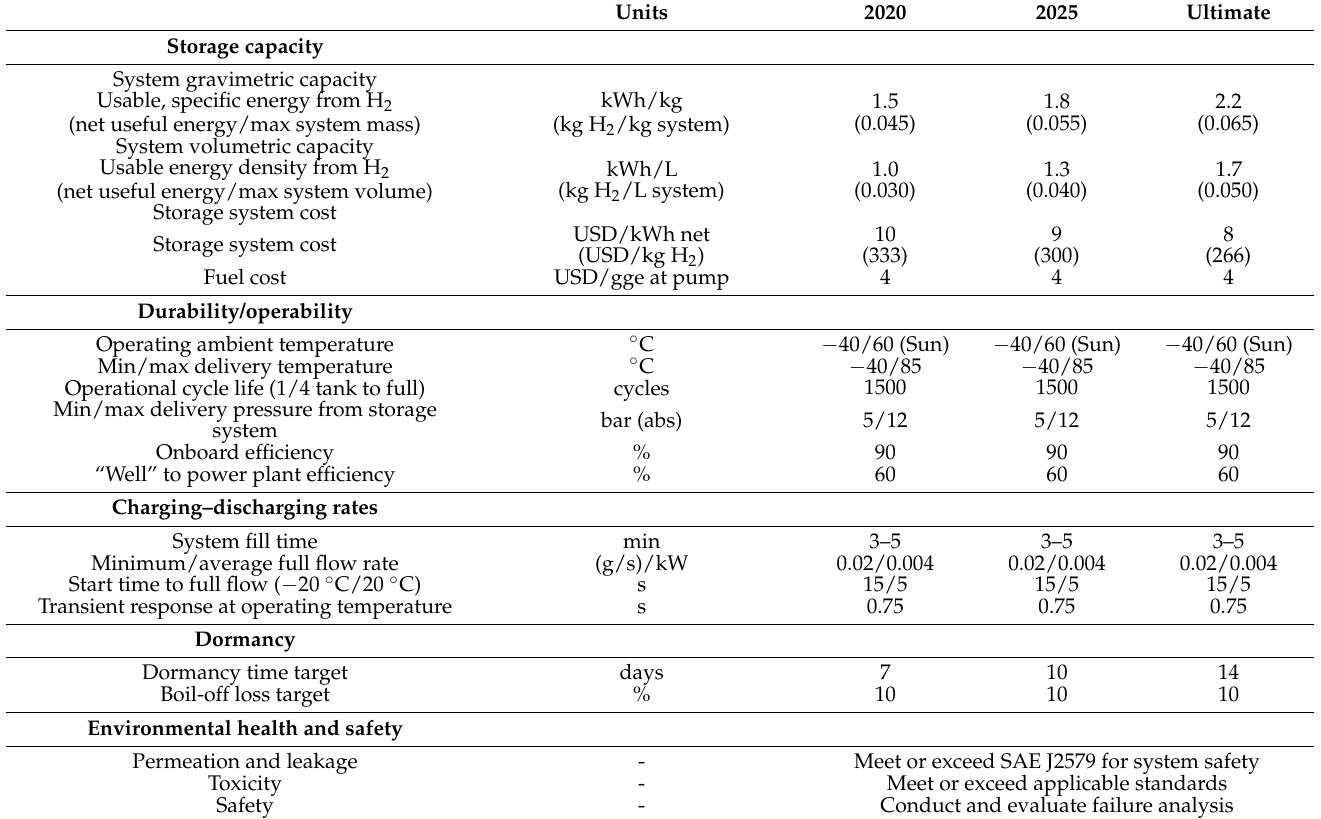
Figure 1. The US DOE targets for hydrogen storage technology. Reproduced from ref. [2]; copyright (2019) with permission from Royal Society of Chemistry, Reproduced from ref. [7]; copyright (2017) with permission from US DOE. Table 1. Technical system targets for onboard hydrogen storage for light-duty fuel cell vehicles. Reproduced with permission from ref. [7] ; copyright (2017), the US DOE.